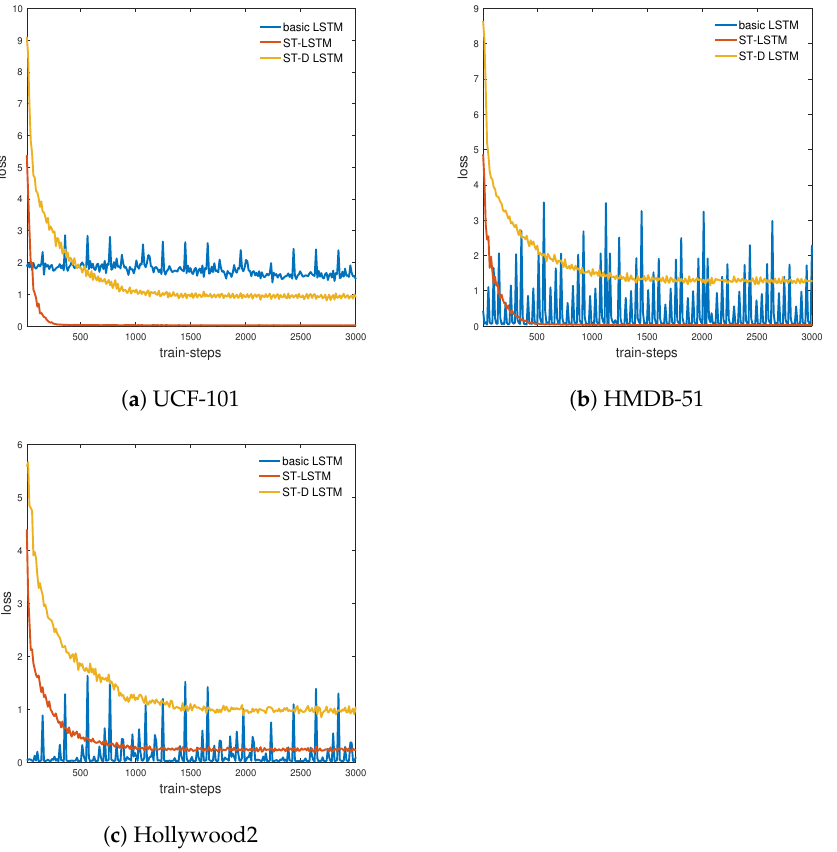
Figure 5. The comparison of different LSTM units on three datasets in